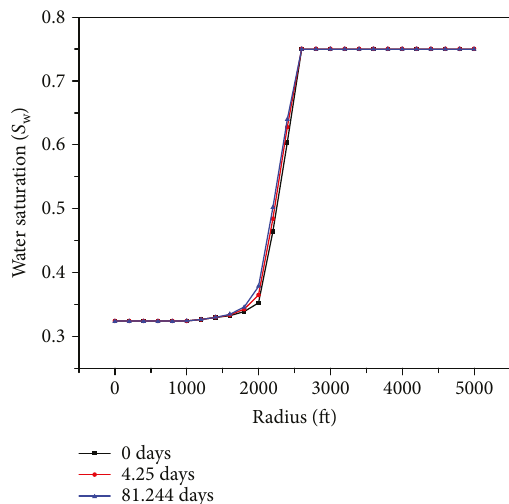
Figure 11: Water saturation pro fi le changes with radial distance.